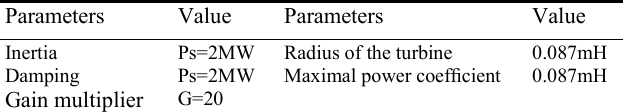
Table 1. Wind Turbine parameters